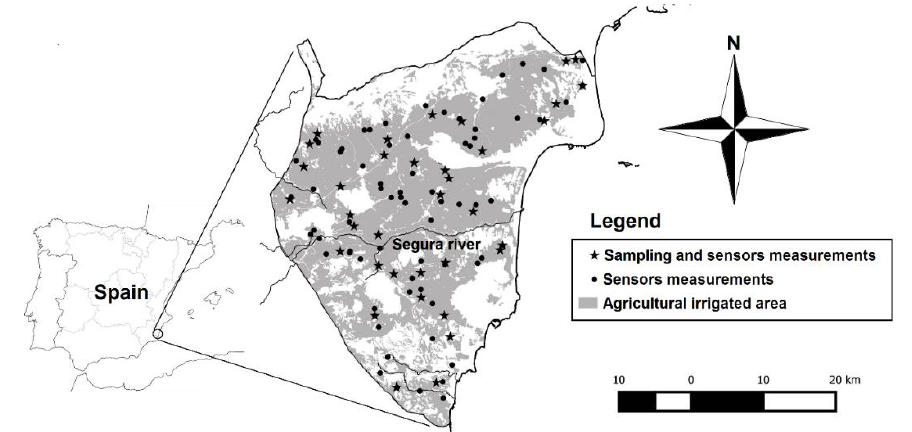
Figure 1. The study area of the Vega Baja del Segura and Baix Vinalopó with the location of the measurement and sampling sites.